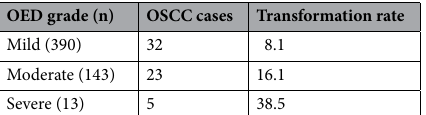
Table 1. Transformation of oral epithelial dysplasia (OED) to oral squamous cell carcinoma